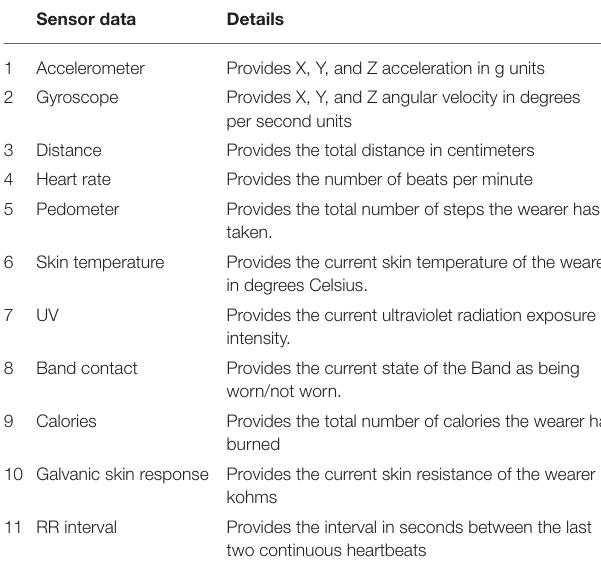
TABLE 1 | List of data collected from the Microsoft Smart Band